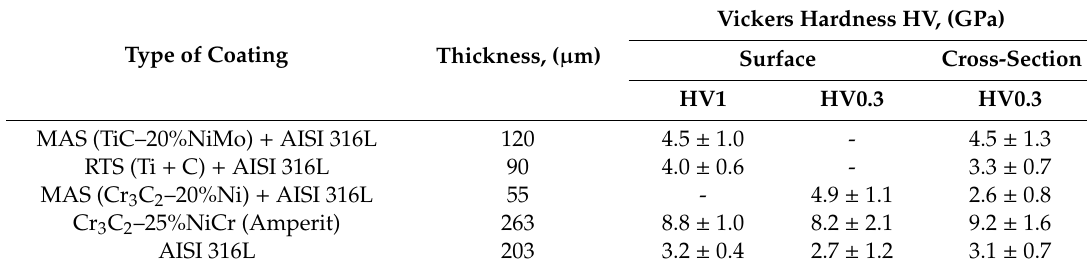
Table 7. Thickness and hardness of the HVOF sprayed coatings.